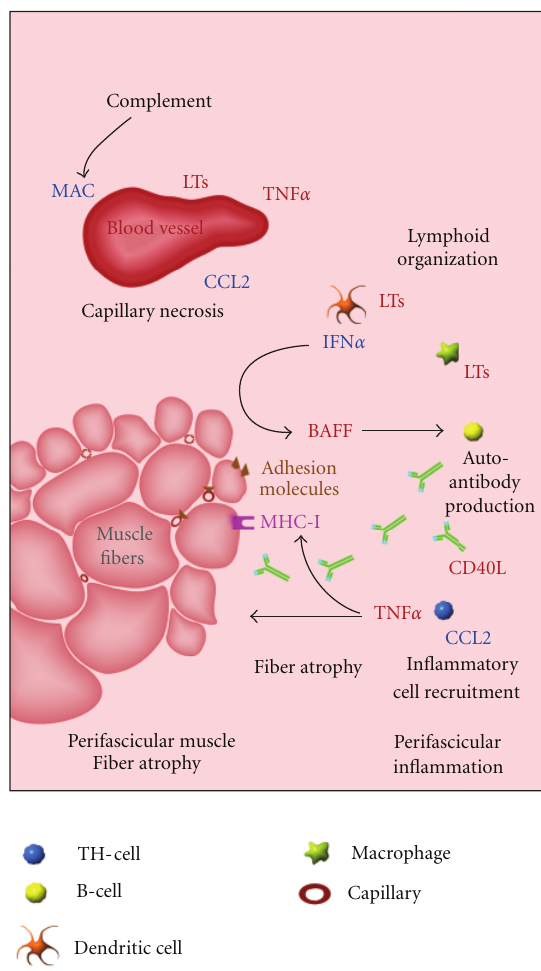
Figure 1: Potential roles for tumor necrosis factor cytokines in the muscle damage associated with dermatomyositis. Based on current know- ledge, a model is developed describing the possible involvement of tumor necrosis factor (TNF) cytokines in the sustained inflammation in perifascicular regions of muscle. Activation of the complement system leads to membrane attack complex (MAC) deposition on blood vessels and subsequent necrosis. Endothelial monocyte chemoattractant protein-1 (CCL2) recruits inflammatory cells that accumulate and organize in perimysial areas. Lymphocytes organize into functional compartments and produce lymphotoxins (LTs), TNF α and CD40L, which further recruit responsive immune cells from the circulation, leading to the buildup of perimysial inflammation. Dendritic cells (DCs) produce IFN α , which stimulates muscle fibers to secrete B-cell activating factor (BAFF). The latter activates B-cells that, in response, begin to produce autoantibodies. TNF α , mostly produced by Th-cells, provokes muscle fiber atrophy and stimulates major histocompatibility complex I (MHC-I) and expression of adhesion